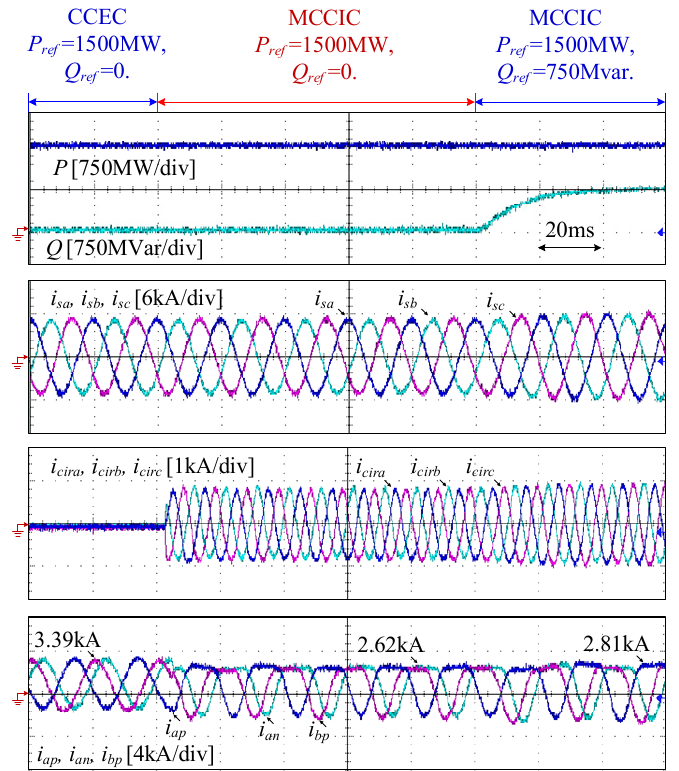
Figure 13. Experimental waveforms of the MMC before and after using the proposed strategy. The operating conditions are set as Similar to the simulation results is that the transfer process of each operating condi- tion is smooth without overshoot and oscillation.